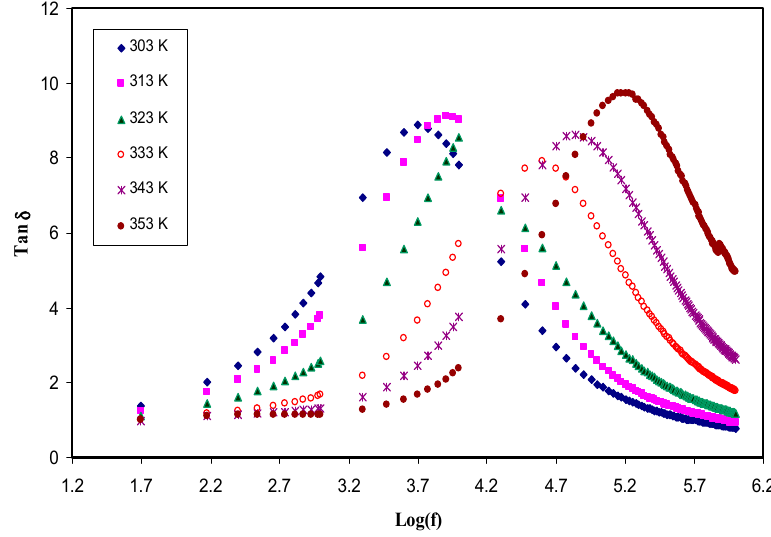
Figure 10. Tan δ plots for the CS: POZ: MgTfsystem at different temperatures.